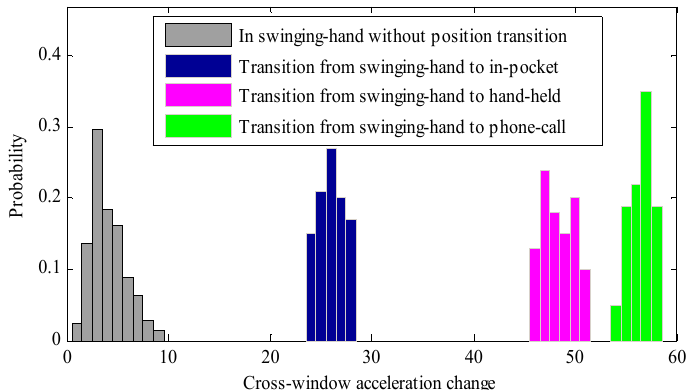
Figure 6. Statistical results of cross-window acceleration change values with and without position transitions for swinging-hand position during normal pedestrian walking.